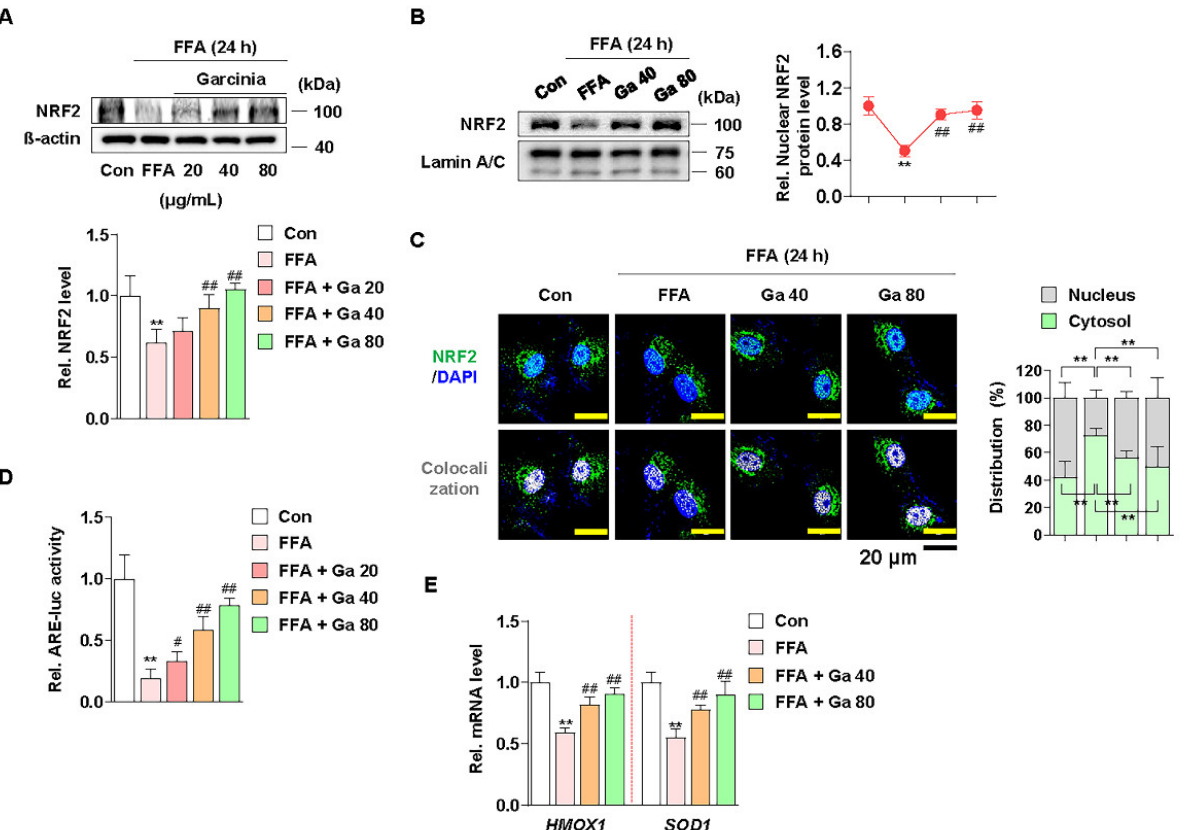
Figure 4. Effect of Garcinia cambogia on NRF2-ARE activation in FFA-induced HepG2 cells. ( A ) Effect of G. cambogia (20–80 µ g/mL) on NRF2 expression in FFA-treated HepG2 cells ( n = 4 per group). ( B ) Effect of G. cambogia on NRF2 nuclear expression in FFA-treated HepG2 cells. Cells were treated with G. cambogia (40 and 80 µ g/mL) for 12 h, and cells were fractionated into nucleus compartment as described in the Methods section ( n = 4 per group). ( C ) Representative immunofluorescence images of NRF2 in FFA-treated HepG2 cells. Colocalized FITC (i.e., NRF2) and DAPI (i.e., nuclei) were quantified using ImageJ software, and relative intensities in the nuclear and cytoplasmic fractions were expressed as a histogram. Scale bars: 20 µ m ( n = 5 per group). ( D ) Effect of G. cambogia on ARE promoter activity in FFA-treated HepG2 cells. ARE-luc vector-transfected HepG2 cells were cotreated FFA and G. cambogia (20–80 µ g/mL) for 12 h and detected ARE promoter activity ( n = 6 per group). ( E ) Effect of G. cambogia (20–80 µ g/mL) on the transcript levels of HMOX1 and SOD1 in FFA-treated HepG2 cells ( n = 5 per group). ** p < 0.01 vs. Con, # p < 0.05 and ## p < 0.01 vs. FFA. Data are mean ± S.D.